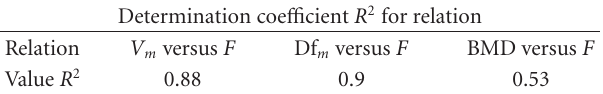
Figure 5: Relation between force F and mean fractal dimension Df m . Table 2: Strength of correlation expressed as determination coe ffi - cient R 2 of force F relation mean volume V m , mean fractal dimen- sion Df m , and BMD.